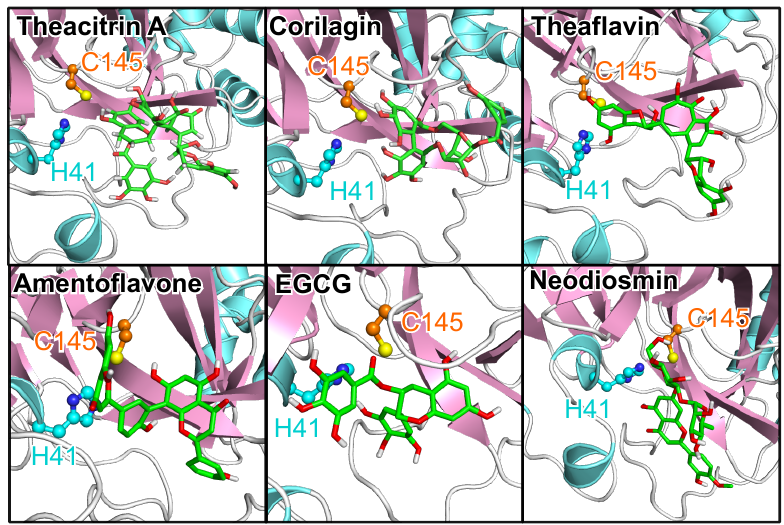
Figure 7. The poses of the six best natural drugs. The top six compounds bind well to the substrate site in terms of both ∆ G and closeness to the catalytic dyad of 3CL pro . The same protein and ligand representation as well as color scheme as in Figure 1 are used.